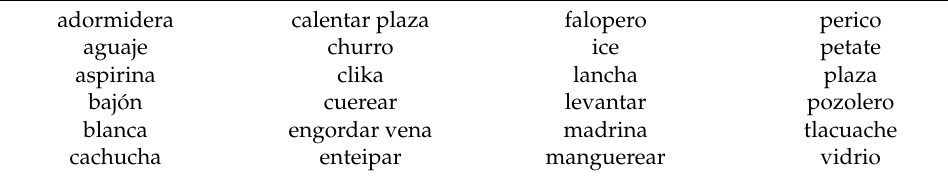
Table 2. Sample of cryptic words to name narco-related concepts.